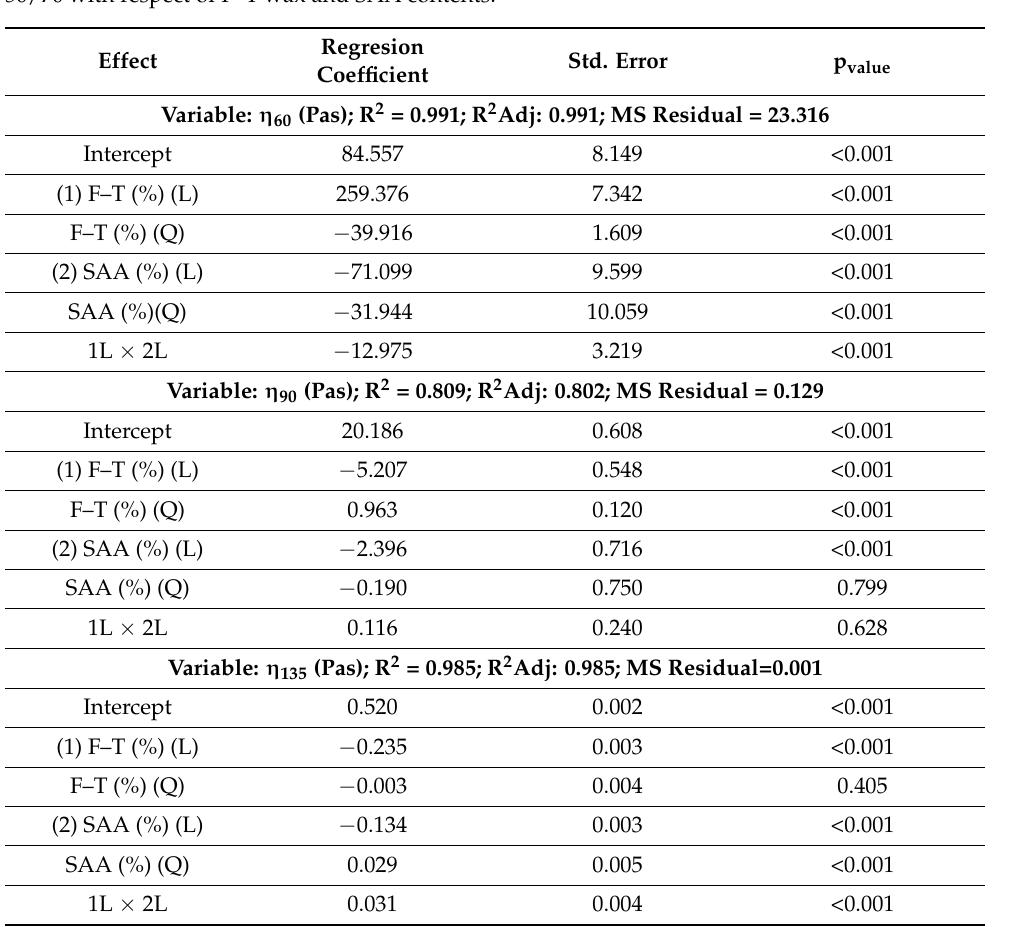
Table 9. Parameters of the regression model for dynamic viscosity variables η 60 , η 90 , η 135 of bitumen 50/70 with respect of F–T wax and SAA